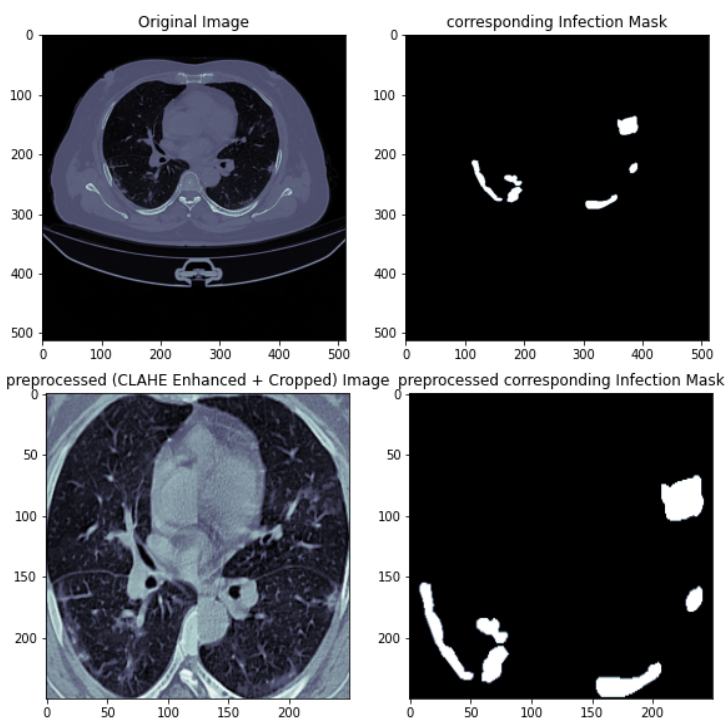
Figure 5. A chest CT scan and its corresponding infection mask before and after cropping.